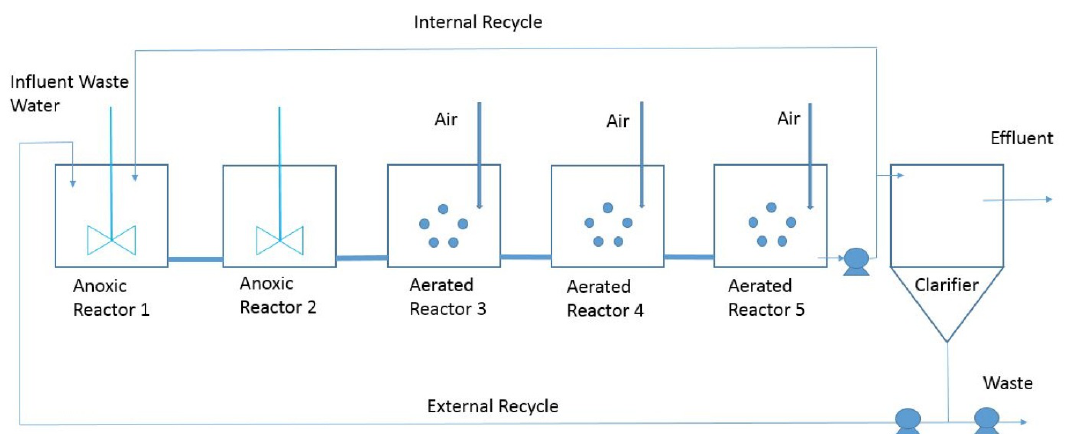
Figure 1. Plant of the Benchmark Simulation Model 1